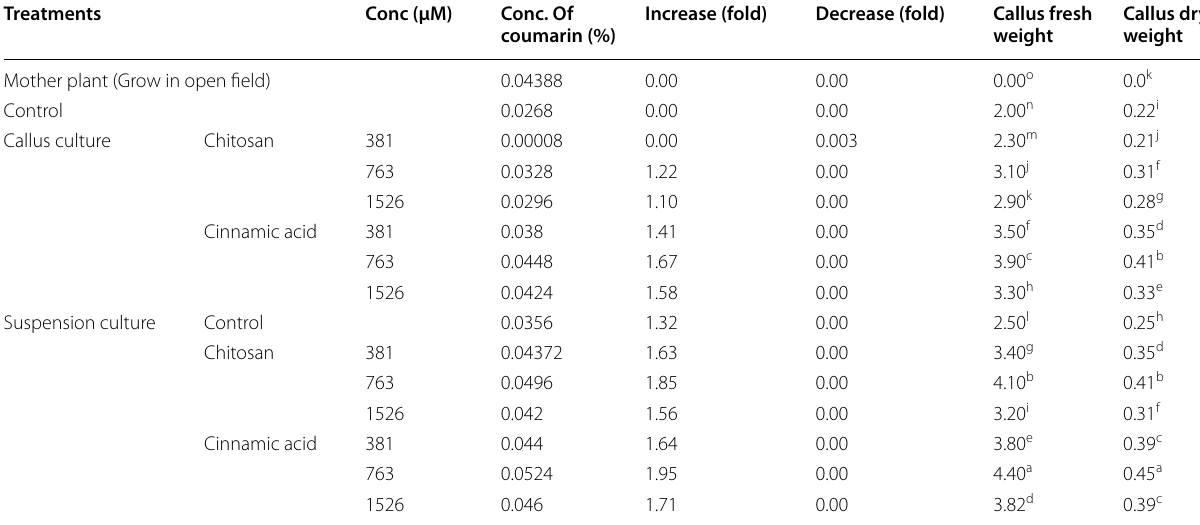
Table 7 Effect of different concentrations of chitosan and cinnamic acid on coumarin content (mg/g fresh weight) in callus and suspension cultures of L.